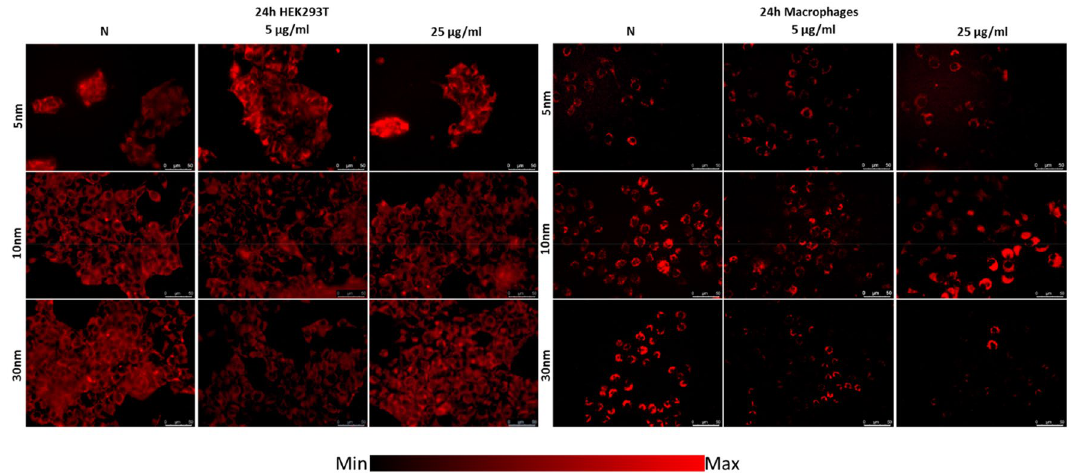
Figure 7. Microscopic images of HEK293T cells and macrophages presenting ROS levels after 24 h of exposure to IONPs with 5 nm, 10 nm and 30 nm diameters in concentrations of 5 µg Fe/ml and 25 µg Fe/ml compared with control group (N).